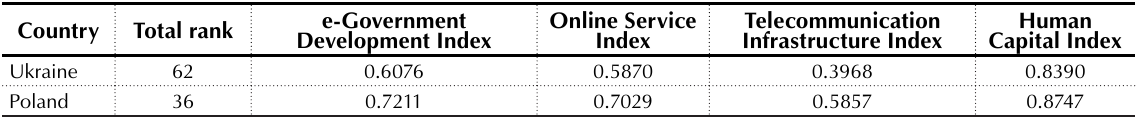
Table 11. Comparison of the IT sphere in Poland and Ukraine